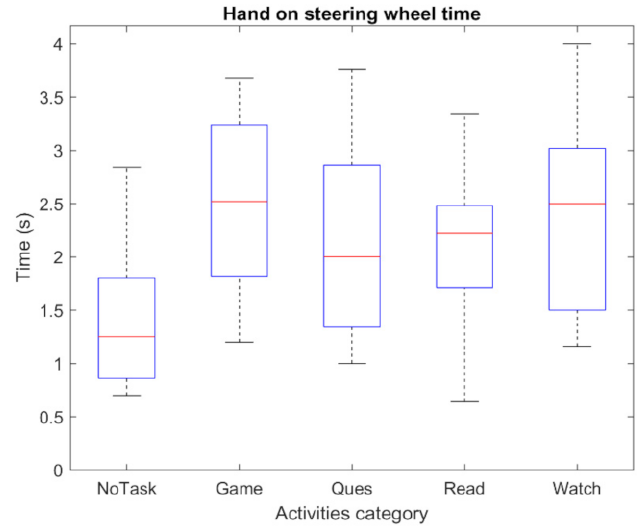
Figure 9. The hand-on-wheel time performance. NoTask refers to the performance in watching road